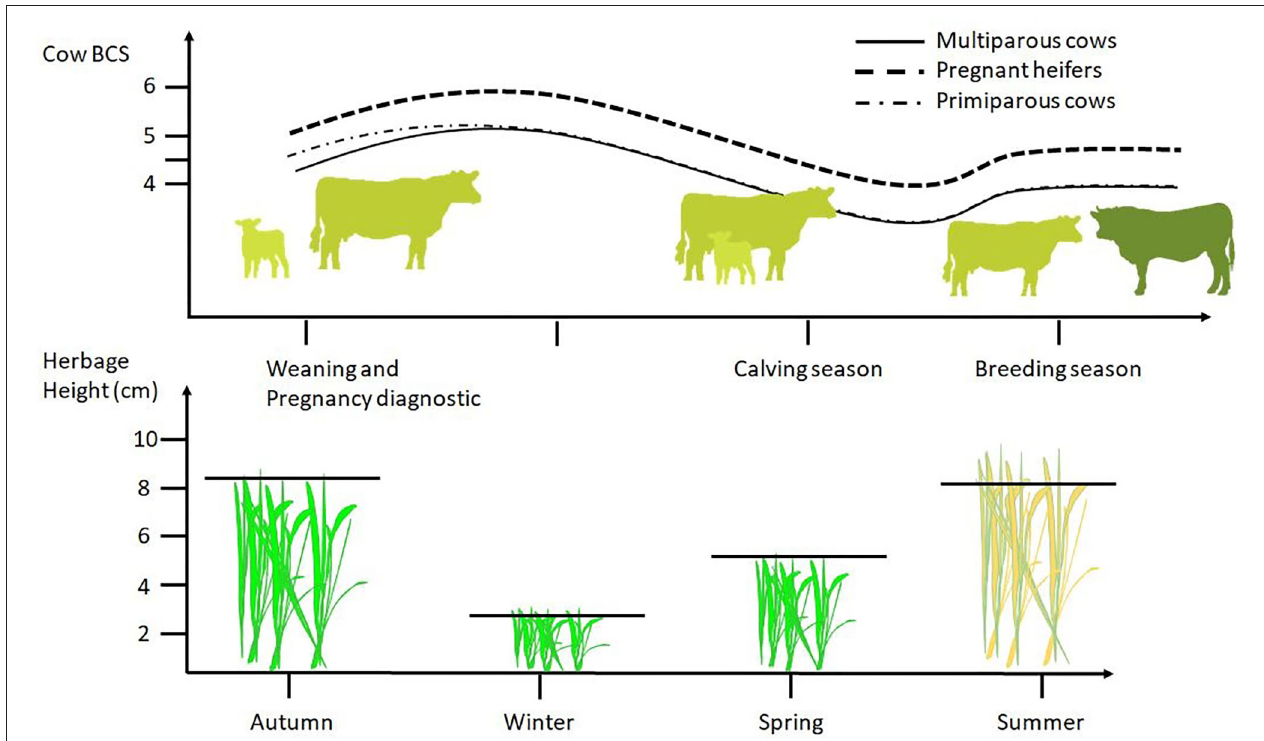
FIGURE 3 | Proposed model for the management of cow body condition (BCS) and herbage height in Campos grasslands (adapted from Soca and Orcasberro, 1992 ). Horizontal bars in the lower part of the figure indicate target sward